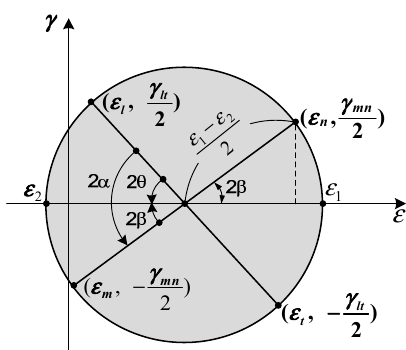
Figure 5. Mohr’s strain circle.